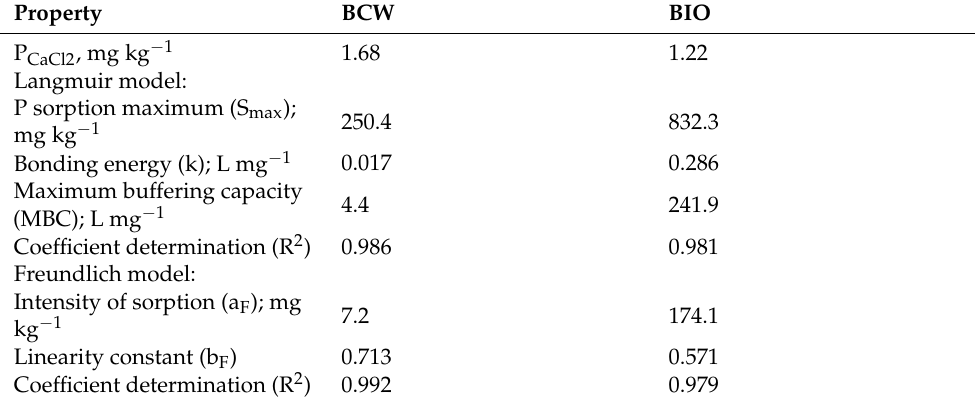
Table 2. Phosphorus sorption parameters of brown coal waste (BCW) and conifer woodchip biochar